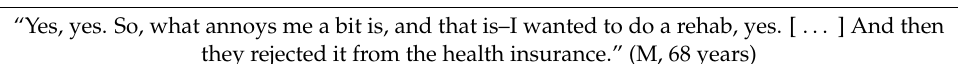
Main Category B “Coping